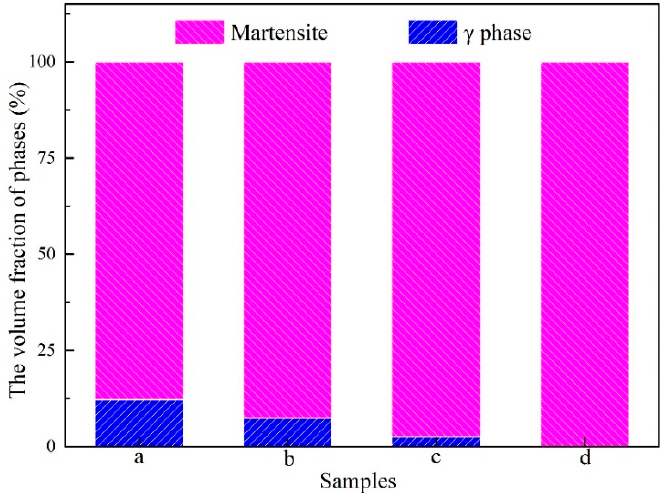
Figure 8. The volume fraction of γ phase and martensite in the samples.